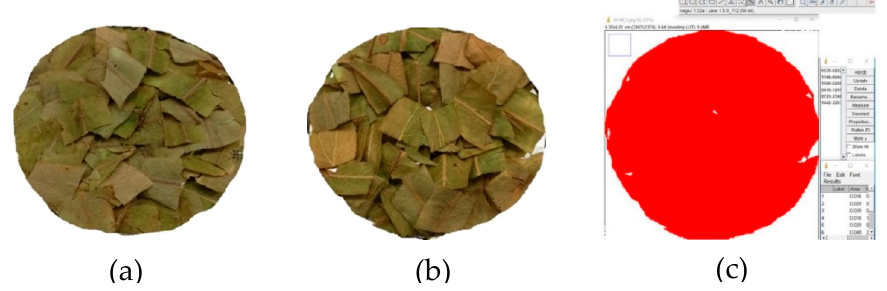
Figure 5. Demonstration of projected area (PA) changing at different temperatures process, ( a ) before